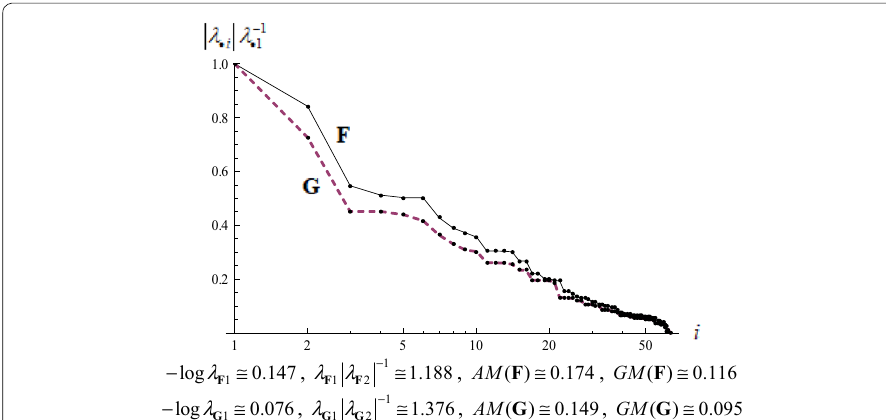
Fig. 1 The moduli of the normalized eigenvalues of the system matrices; Greece